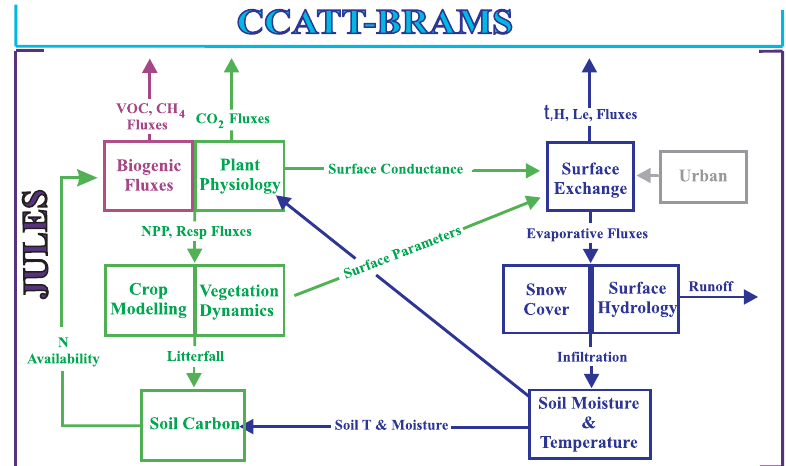
Fig. 1. Structure of JULES 3.0 (adapted from http://www.jchmr.org/jules/management/).